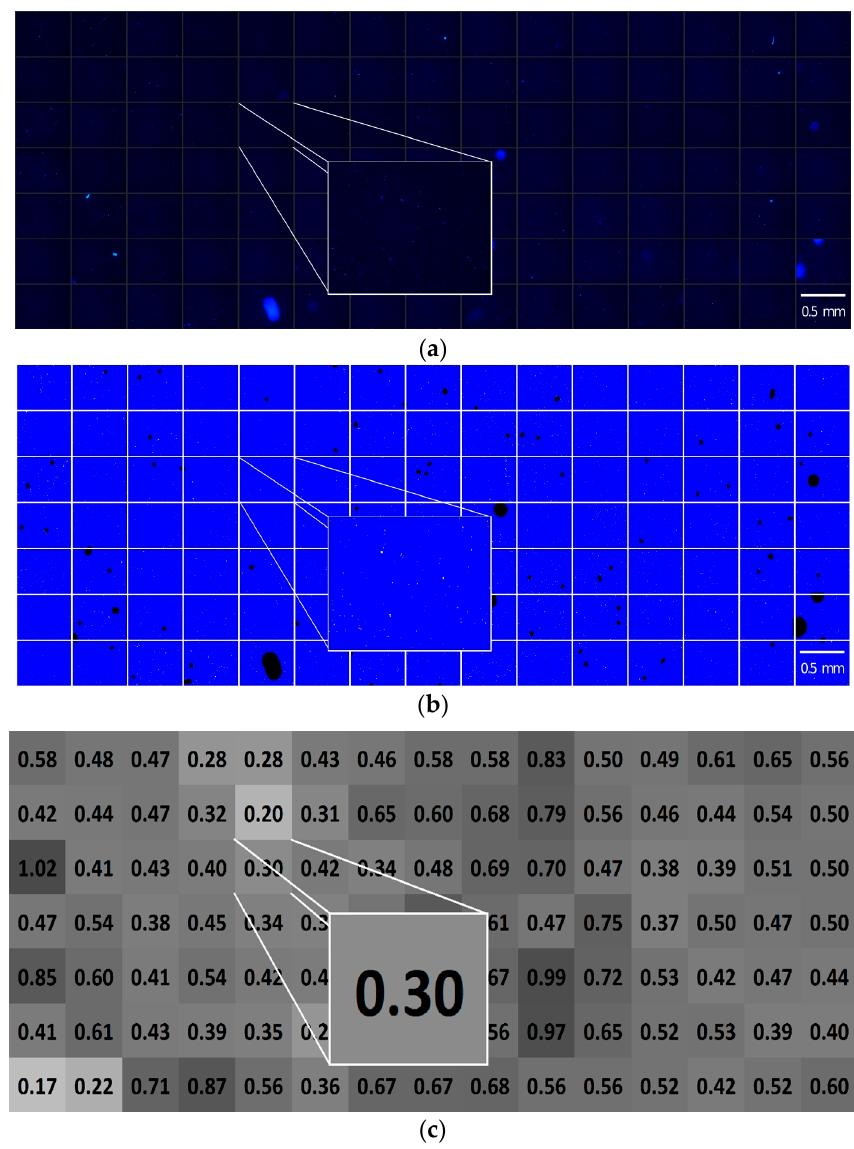
Figure 2. Exemplary procedure for the estimation of bacterial coverage on a glass surface ( a ) Aligned microscopic images (105); ( b ) Overview image including the results of segmentation; ( c ) Calculated bacterial surface coverage for each image.